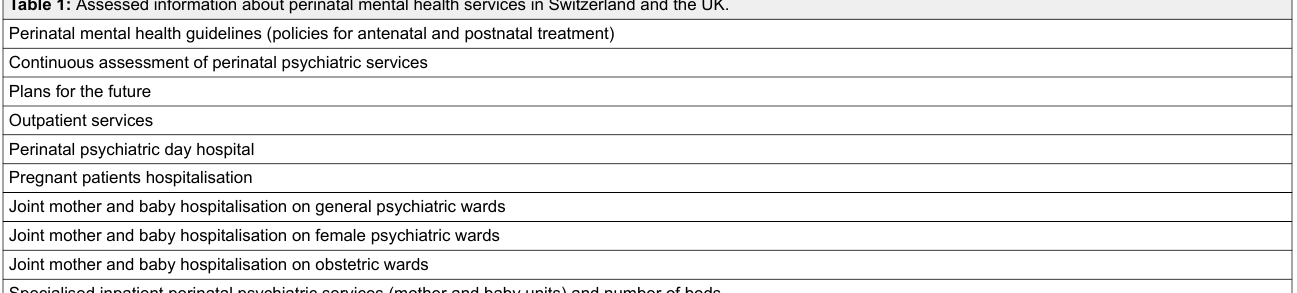
Table 1: Assessed information about perinatal mental health services in Switzerland and the UK. Perinatal mental health guidelines (policies for antenatal and postnatal treatment) Continuous assessment of perinatal psychiatric